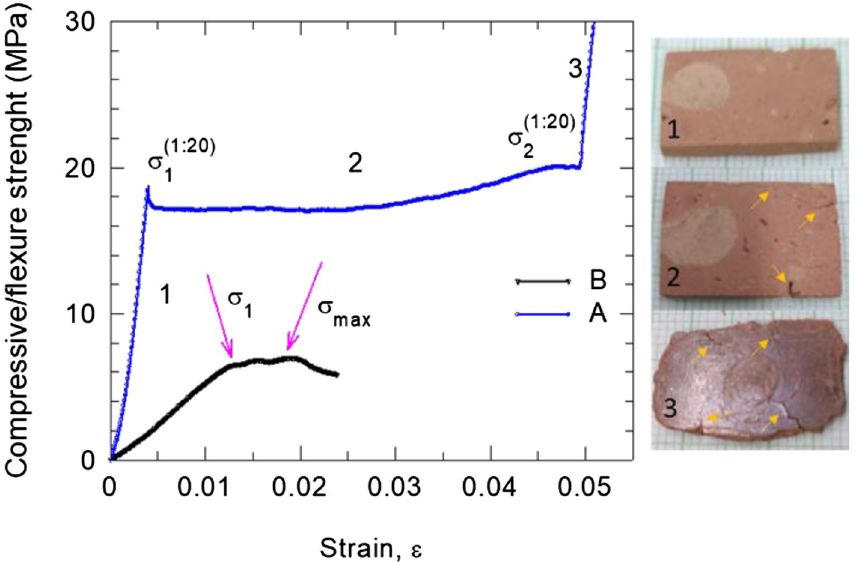
Figure 7. Compressive strength curves taken on the burnt brick from Romula: ( A ) compressive curve of the samples at a scale size 1:20 of the original burnt brick; ( B) compressive curve on cubic samples (standard conditions EN1926:2006). Notations are: σ 1 —compressive strength at the first crack (curve B); σ max —maximum compressive strength (curve B); σ 1 1:20 —compressive strength at the first crack (curve A); σ 2 1:20 —intermediate compressive strength (curve A); region 1—0–σ 1 1:20 first crack formation (curve A); region 2—σ 1 1:20 –σ 2 1:20 cracks development and compaction of the sample (curve A); region 3—> σ 2 1:20 compact material almost without